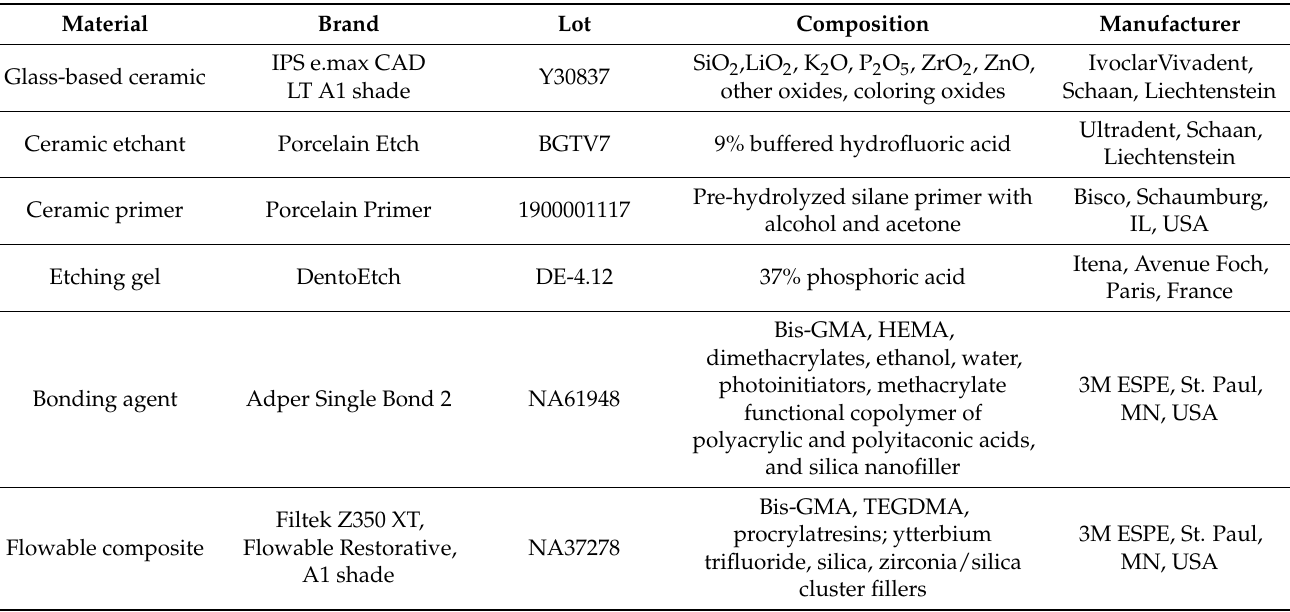
Table 1. Specifications of the materials used in the study.